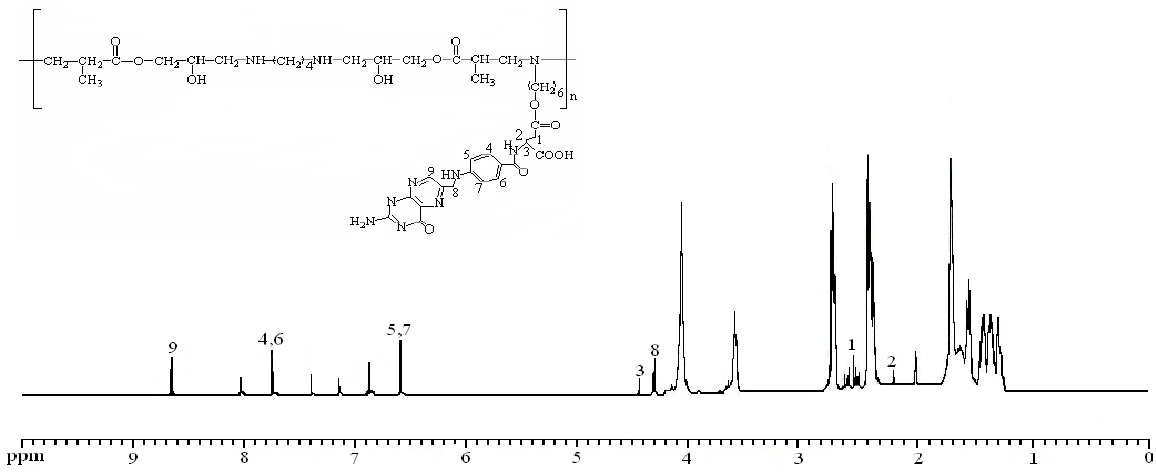
Figure 1. 1 H-NMR spectrum of EPAE-FA.